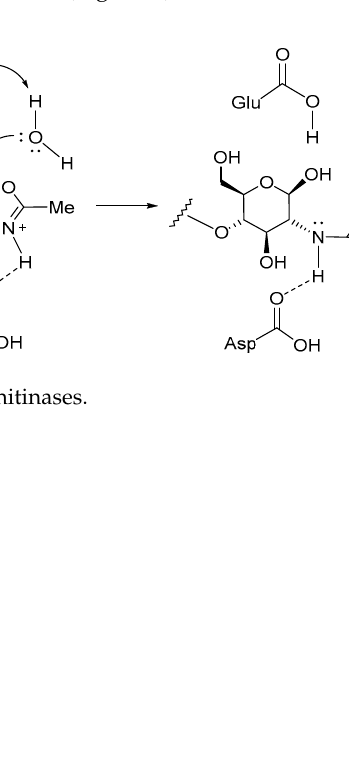
Figure 3. AfChiB1 crystal structure protein data bank with code 3CH9 (PDB: 3CH9) and structural alignment with consensus homology models. ( A ) Molecular electrostatic potential (MEP) surface and catalytic cavity (highlighted by a rectangular form) of chitinase AfChiB1; blue, red and white colored regions indicate positive, negative and zero values of MEP, respectively. ( B ) Structural alignment of the fungi consensus model, and human consensus chitinases. ( C ) Catalytic site of fungi-predicted structures; 3CH9 representation is colored in blue. ( D ) Structural alignment of hu- man consensus model against 3CH9 colored in blue. Key residue differences are highlighted by ball and stick representation.